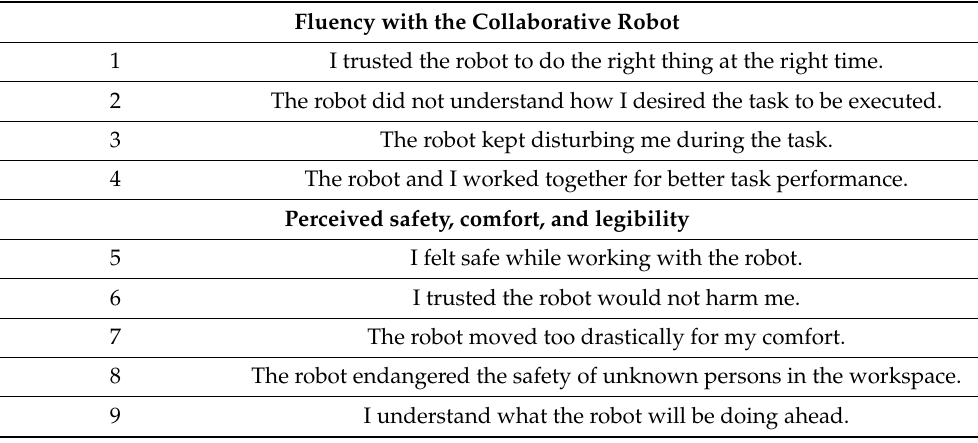
( c ) Figure 6. Detection of persons through object detection algorithm, ( a ) operator in blue and uniden- tified person in red; ( b ) authorized operator; ( c ) operator and unidentified person. Detection of specific poses of the operator is shown in Figure 7, the initial is the de- tection of the pose of the operator when interfering in assembly, and the latter two are the poses of the operator while placing objects himself. It is pertinent to mention here that the contingencies were adopted only when a particular pose detected is complemented by the position of the robot at the same location. This is because, while performing parallel op- erations, the same pose could be detected while the cobot may be operating at some other place.